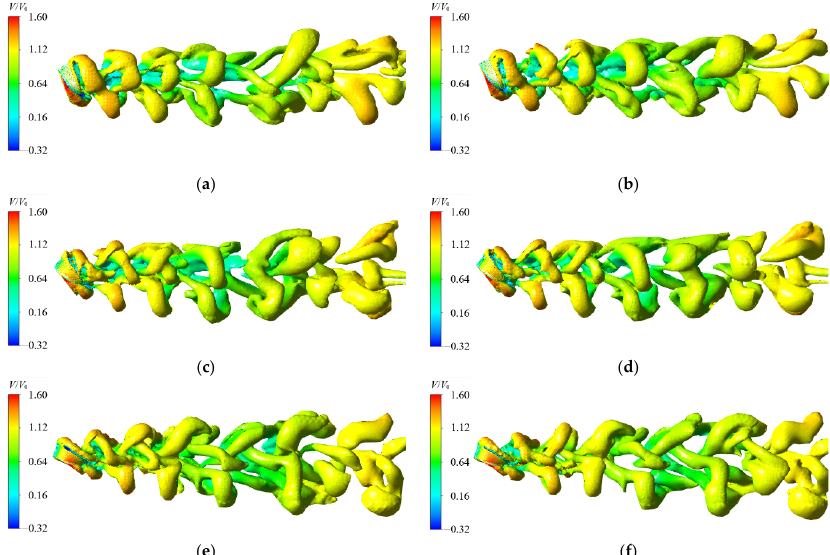
Figure 22. Vorticity Iso-surfaces colored by velocity for the two configurations: ( a ) DT for  = 20°; ( b ) RDT for  = 20°; ( c ) DT for  = 40°; ( d ) RDT for  = 40°; ( e ) DT for  = 60°; ( f ) RDT for  = ◦ ; ( c ) DT for γ = 40 ◦ ; ( d ) RDT for γ = 40 ◦ ; ( e ) DT for γ = 60 ◦ ; ( f ) RDT for γ = 60 ◦ 60°. ( b ) RDT for γ = 20